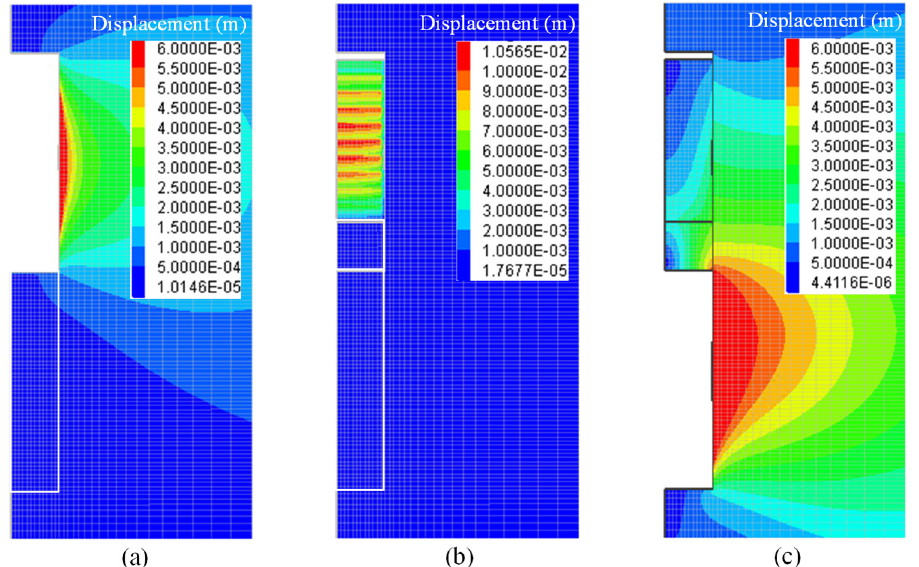
Figure 11. Distributions of the displacement with the Soft Soil model at a mine depth of 200 m for different simulation steps of ( a ) excavating the overlying stope; ( b ) backfilling the mined ‐ out over ‐ lying stope; and ( c ) extracting the underlying stope.